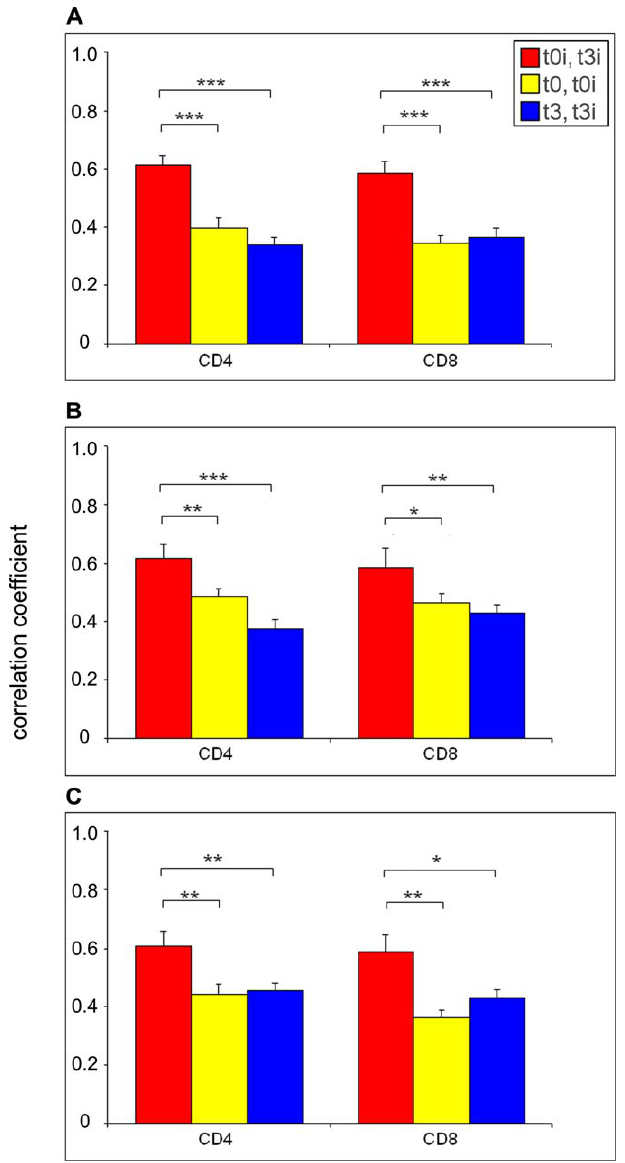
Figure 6. The Pre-AHCT Donor Gene Expression Profile Correlates with the Recipient Expression Profile Examined One Year Post-AHCT The Pearson correlation coefficient (rho) over the expression vectors of 711 informative genes (listed in Table S3) was calculated between members of all matching donor–recipient pairs, and all donor–donor and recipient–recipient pairs, and then averaged for each group. Bar graphs show the mean Pearson correlation coefficient between individual donors on day 0 with their recipient on day 365 ( t 0i (cid:2) t 3i) (red bar), between individual donors and all other donors on day 0 ( t 0i (cid:2) t 0) (yellow bar), and between individual recipients and all other recipients on day 365 ( t 3i (cid:2) t3) (blue bar). Data are from all (40) donor–recipient pairs (A), or from pairs in which the recipient presented cGVHD (B), or not (C). Error bars represent the standard error of the mean. The vector of ( t 0i (cid:2) t 3i) correlations was compared to the vectors of ( t 0i (cid:2) t 0) and ( t 3i (cid:2) t 3) correlations using Student’s t-test, to determine whether the differences between these observed sample pair correlation groups are statistically significant. t-Test p -values relative to ( t 0i (cid:2) t 3i) are labeled as follows: *, 0.01 , p , 0.05; **, 0.001 , p , 0.01; ***, p , 10 (cid:2) 6